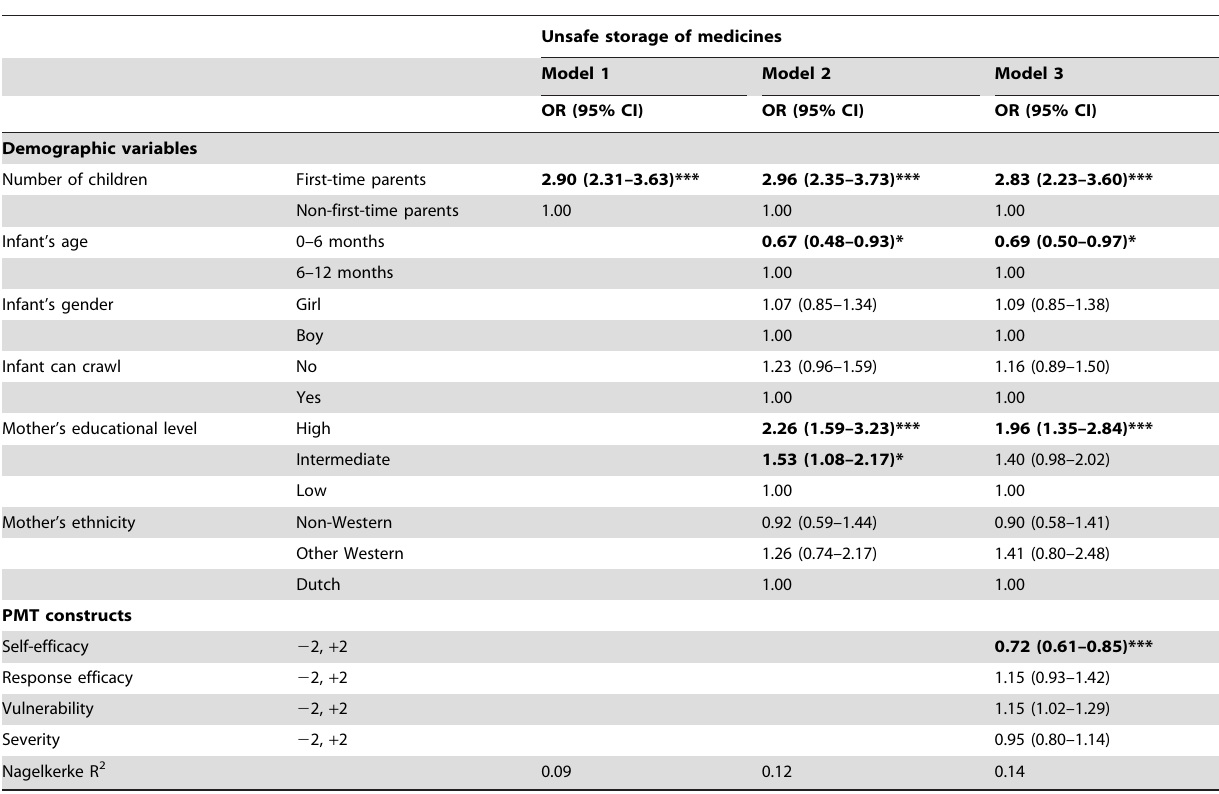
Table 7. Odds ratios (OR), 95% confidence intervals and explained variance (Nagelkerke R 2 ) from multiple logistic regression analyses with reported unsafe storage medicines as dependent variable and number of children (Model 1), other